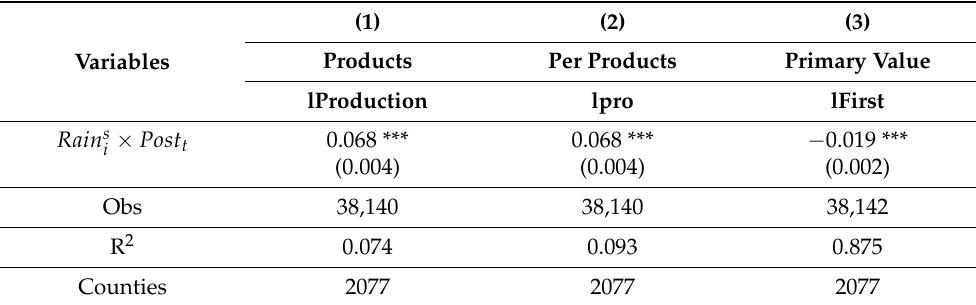
Table 10. The impact of the snow disaster on the output and quality of agricultural products.